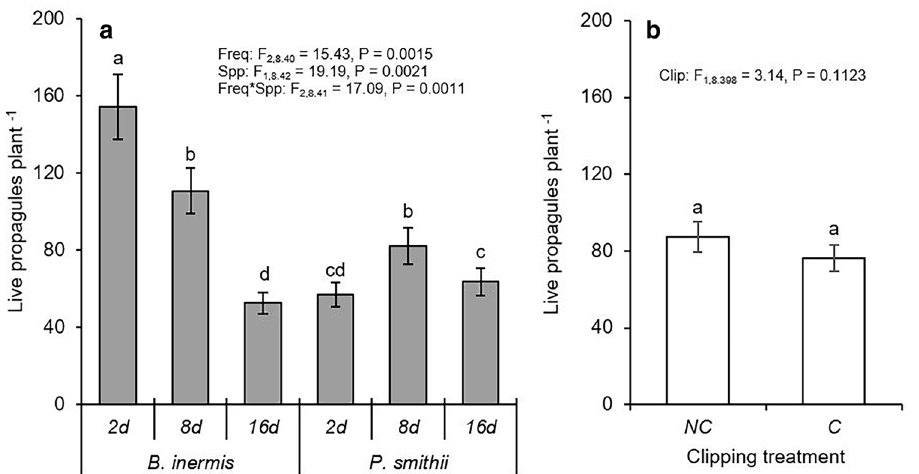
Figure 4. Effect of ( a ) precipitation frequency and ( b ) clipping on number of live propagules per plant of Bromus inermis and Pascopyrum smithii. Values are mean ± SE based upon the statistical model. Significant differences at p -value < 0.05 indicated by different letters. Interaction results are shown when p -value < 0.05. Full results are shown in Table S5.